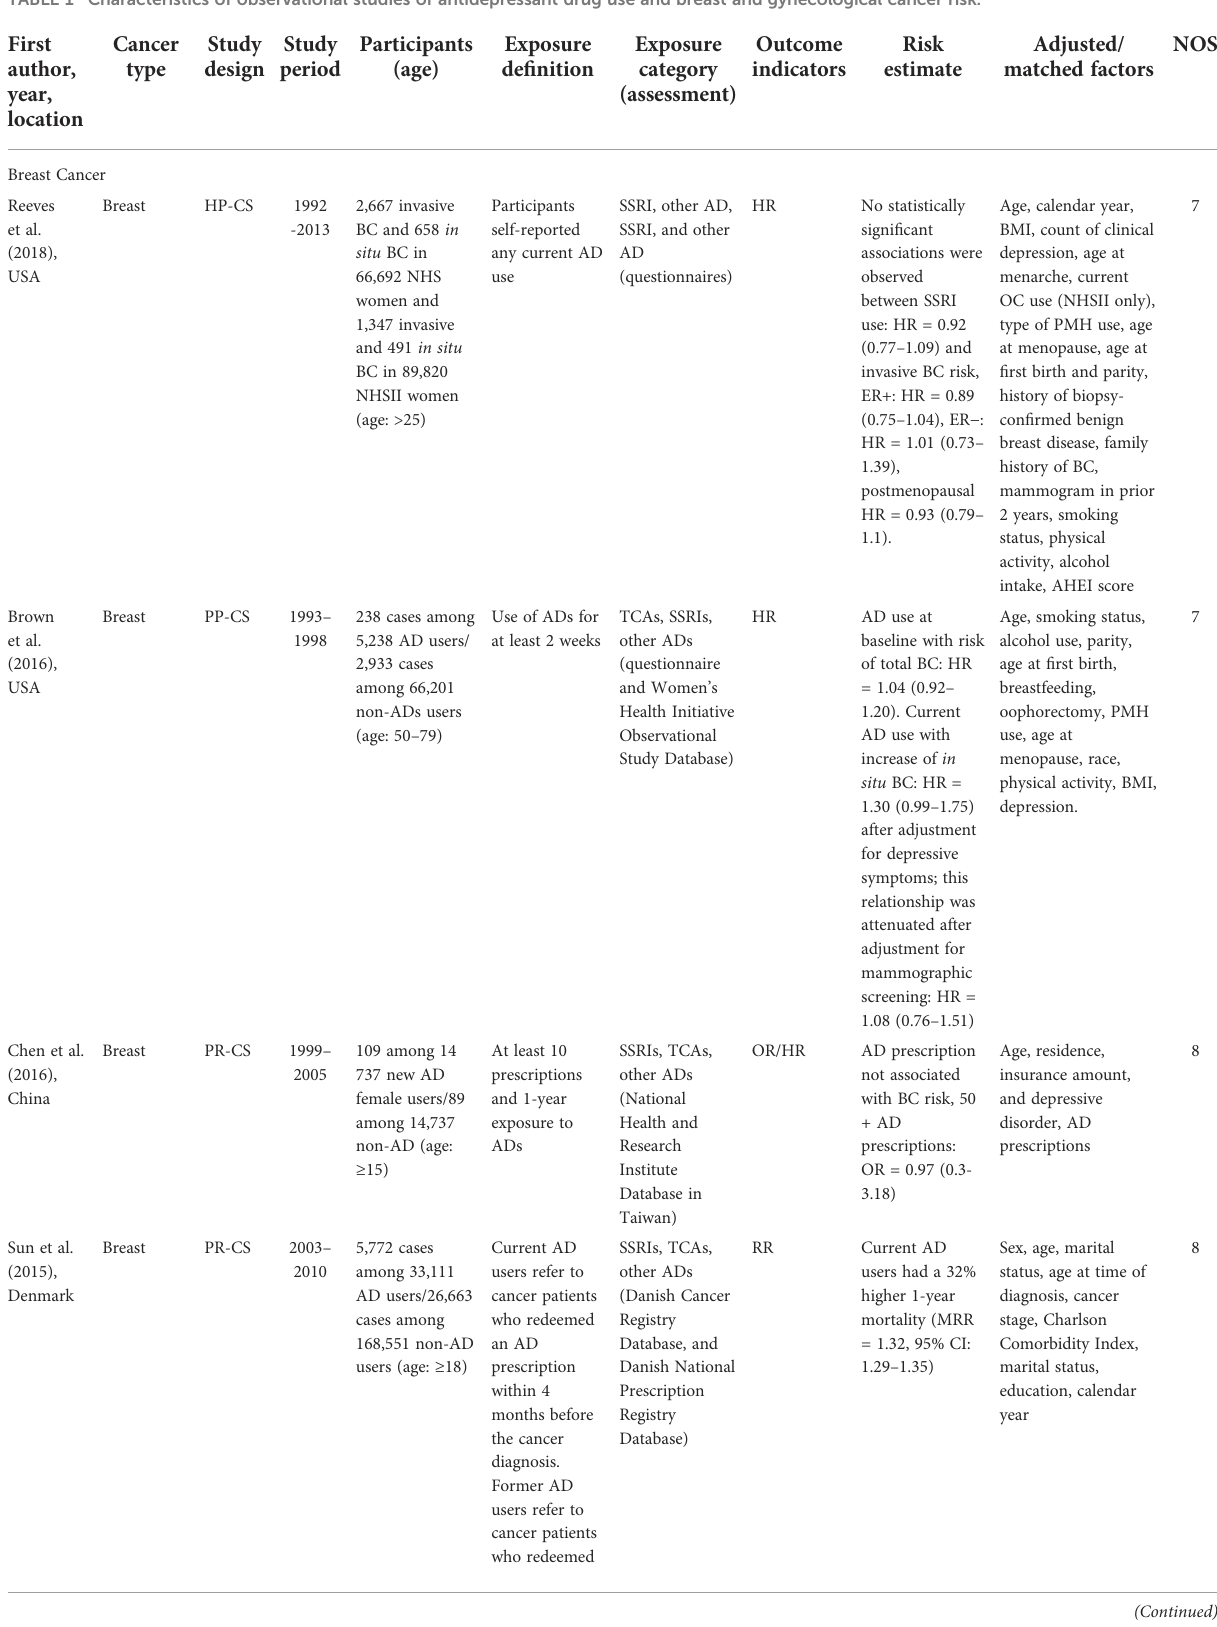
TABLE 1 Characteristics of observational studies of antidepressant drug use and breast and gynecological cancer